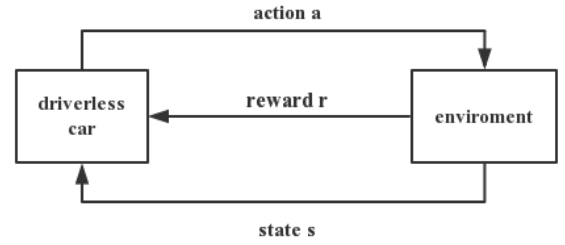
Figure 9. The frame of reinforcement learning.